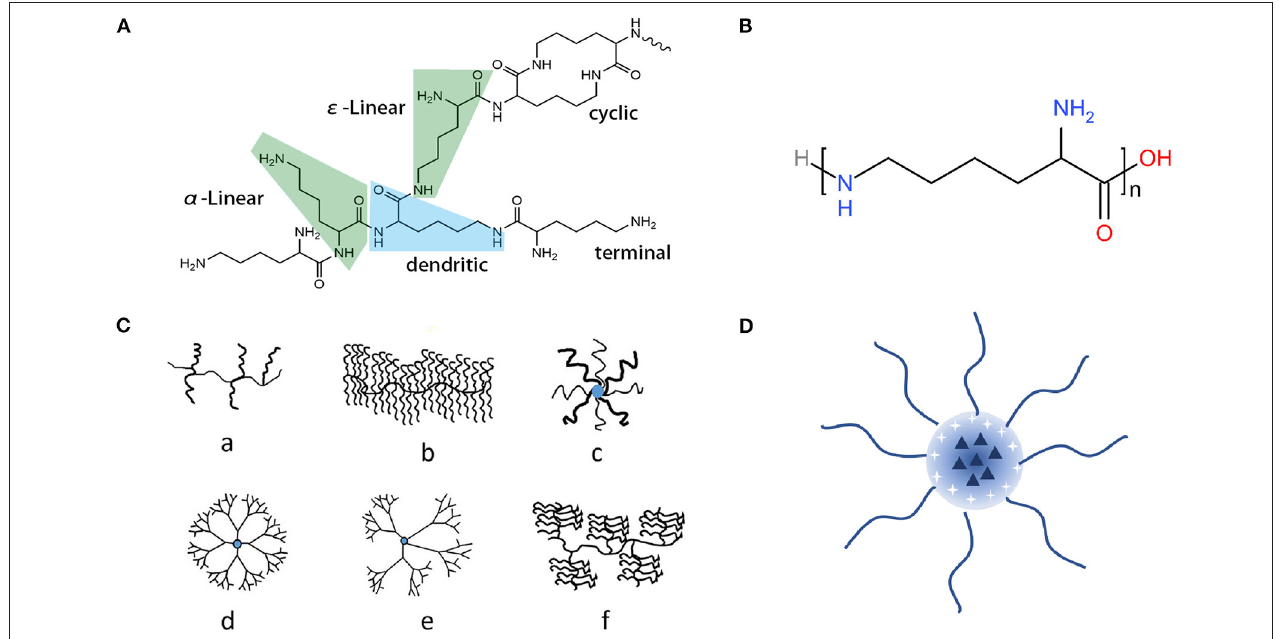
FIGURE 1 | Structures of PLL-related polymers with different morphologies. (A) The molecular structure of PLL (Ge et al., 2019); (B) The structure of EPL, one of the linear PLL forms; (C) Different molecular structure polylysine derivatives ( Shi et al., 2015): (a) graft, (b) brush, (c) star architectures, (d) dendrimer, (e) hyperbranched, and (f) dendrigraft; (D) Self-assembled nanoparticles of PLL derivatives (Li Y. et al.,